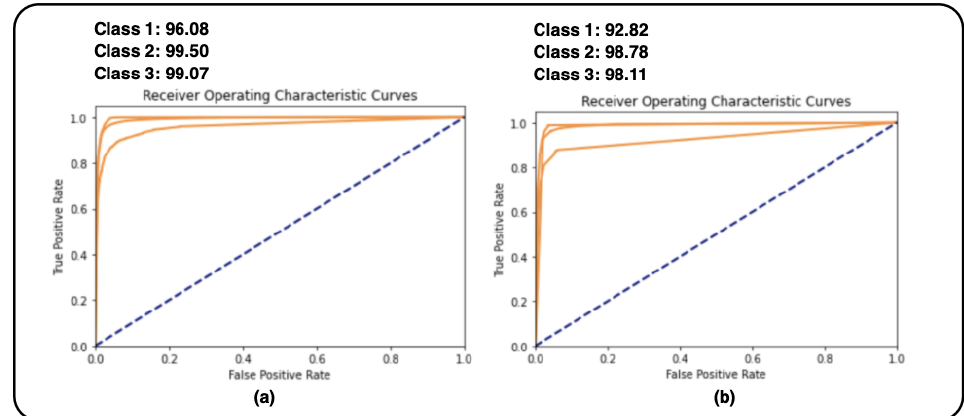
Figure 10. AUC-ROC curve performance of two random forest models with different parameters. ( a ) Random forest with 44 trees and using the oversampling technique for the minority class. ( b ) Random forest with 20 trees and using the oversampling technique for the minority class and under-sampling technique for the majority class.